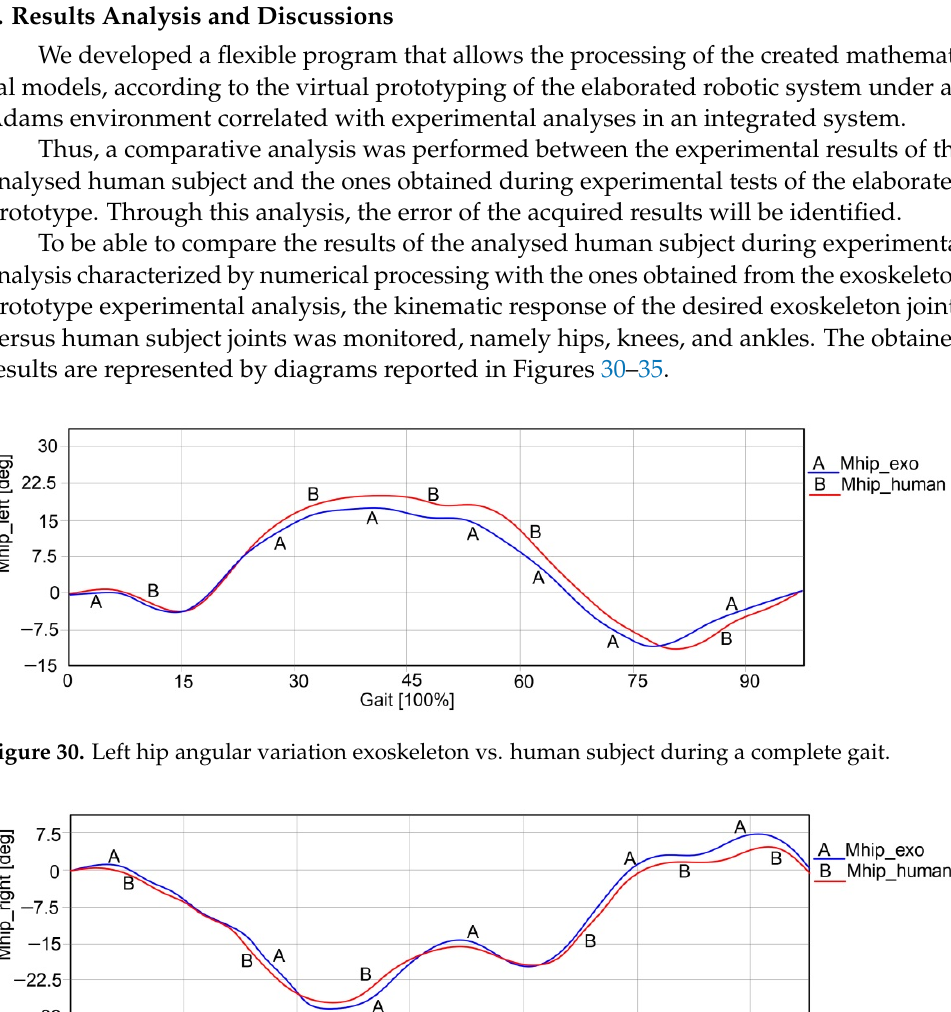
Figure 32. Right knee angular variation exoskeleton vs. human subject during a complete gait.